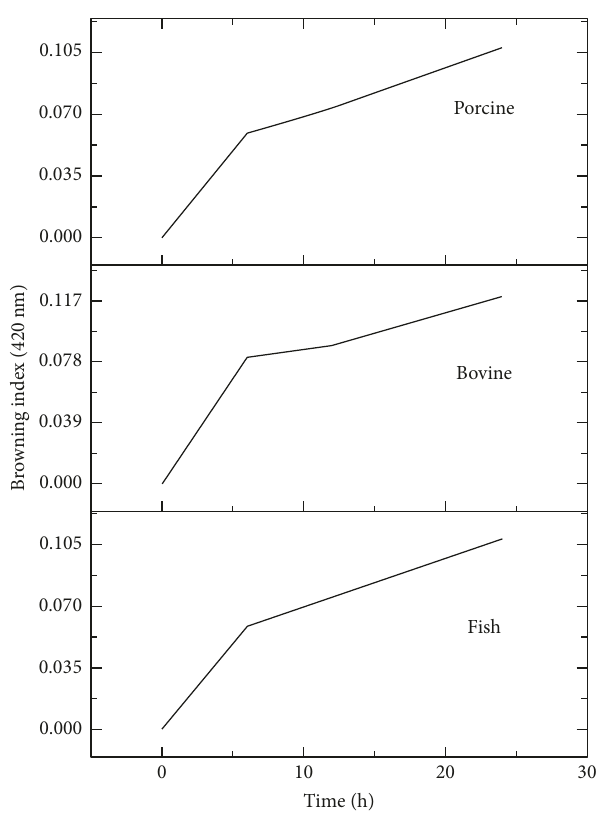
Figure1:Browningindexofxylose-inducednonbrowningofgelatin from different sources (fish, bovine, and porcine) at 95 ∘ C.